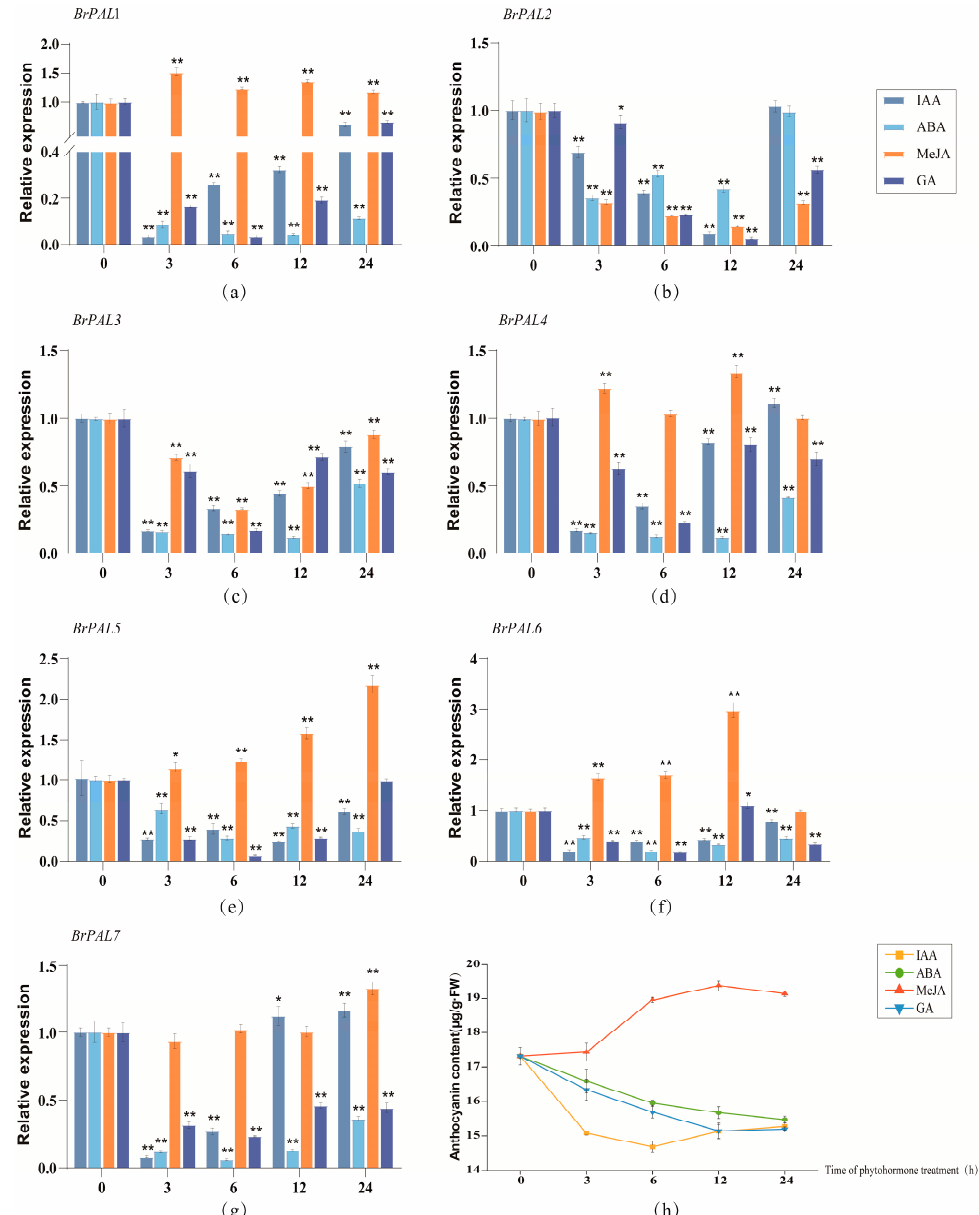
Figure 9. Relative expression level and anthocyanin content of BrPAL gene at 0, 3, 6, 12, 24 h under hormone treatment. ( a – g ) Histogram of relative expression of PAL gene in purple cabbage under IAA, ABA, MeJA, and GA; ( h ) line graph of anthocyanin content in purple cabbage under hormone treatment; Data represent the mean of triplicate with three biological replicates. * indicates significant difference ( p value < 0.05); ** indicates extremely significant difference ( p value < 0.01).